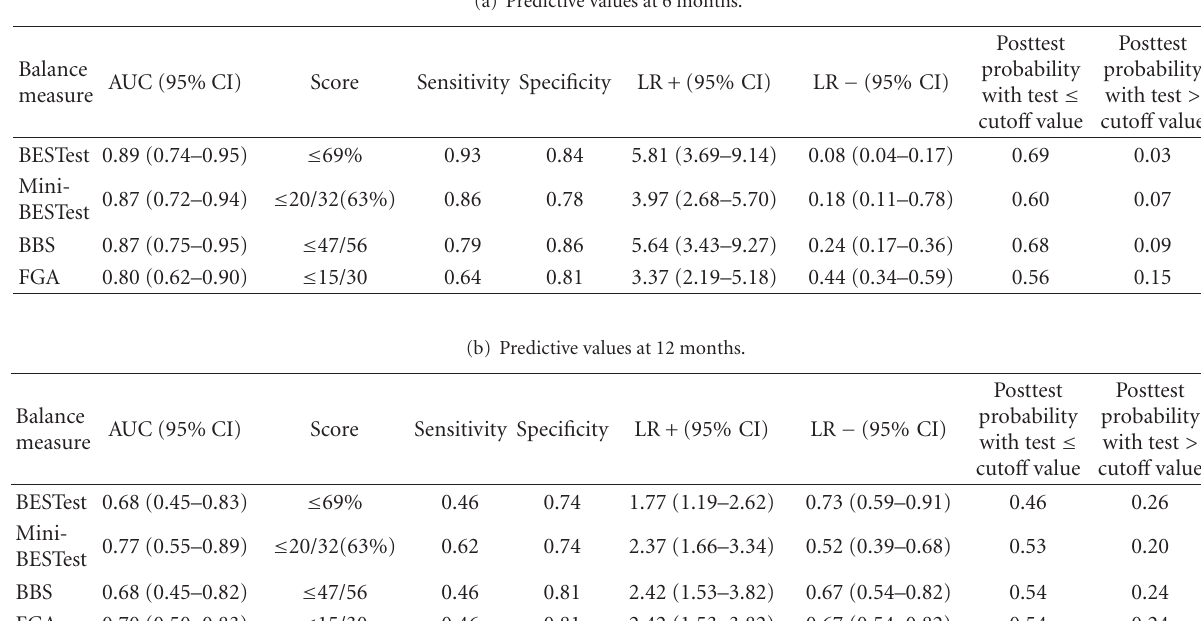
(a) Predictive values at 6